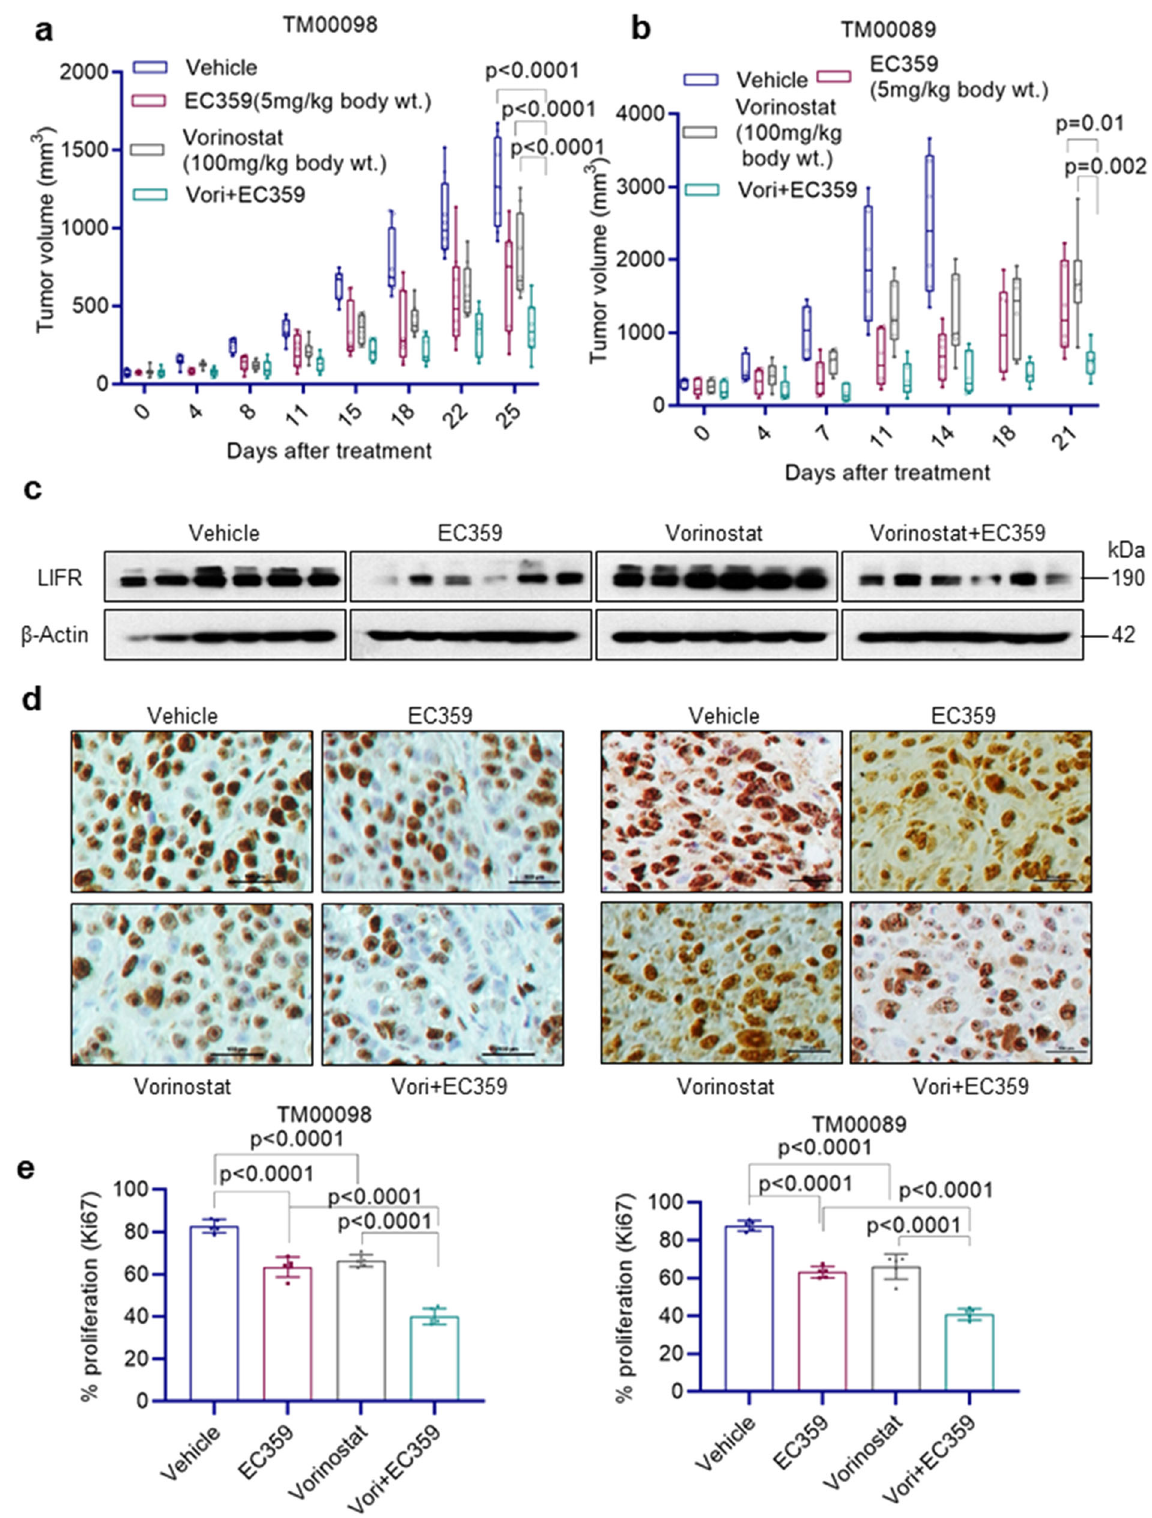
Fig. 7 EC359 enhanced HDACi ability to reduce tumor growth in PDX models of TNBC. a , b Female SCID mice were implanted with 2 mm 3 pieces of PDX tumors TM00098 ( a ) TM00089 ( b ) into the fl anks and randomized for treatment when the tumor volume reached ~150 mm 3 . TNBC PDX tumors ( n = 6 – 8) were treated with vehicle or EC359 or vorinostat or combination. Tumor volumes are shown in the graph. Control mice in panel b were euthanized on day 14 because of higher tumor volume. c Total protein lysates from vehicle and treated TM00089 PDX tumors were analyzed for levels of LIFR using western blotting. d , e Ki67 expression as a marker of proliferation was analyzed by IHC and quantitated. Error bars represent SD. In a , p -values were calculated using two-way ANOVA. In b , p -values were calculated using multiple unpaired t test. In e , p -values were calculated using one- way